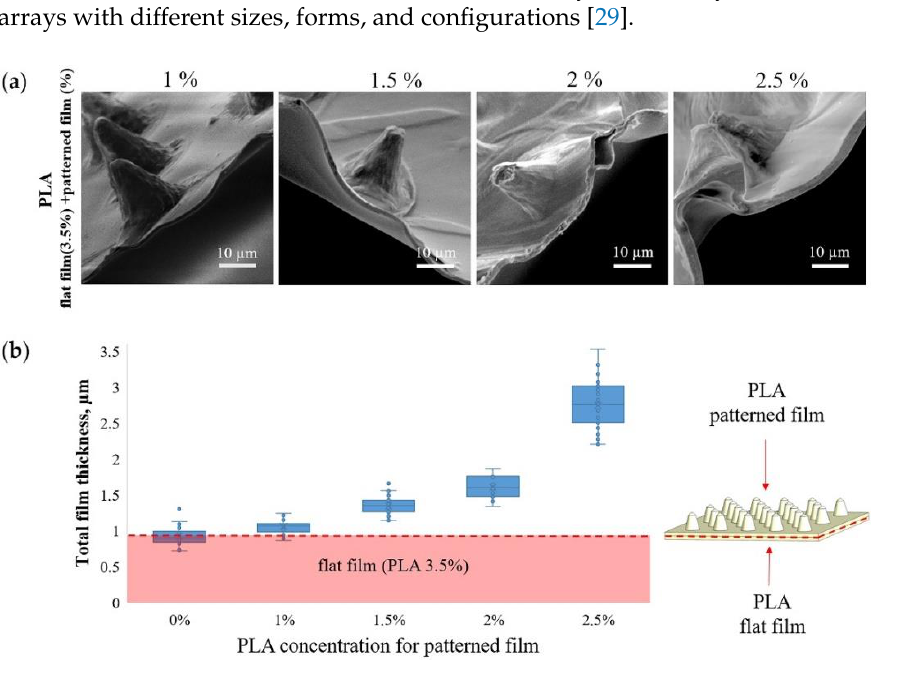
Figure 2. SEM images of microchamber arrays edge, obtained at different concentrations of PLA in the patterned film ( a ) and the dependence of the film thickness on the PLA concentration ( b ).